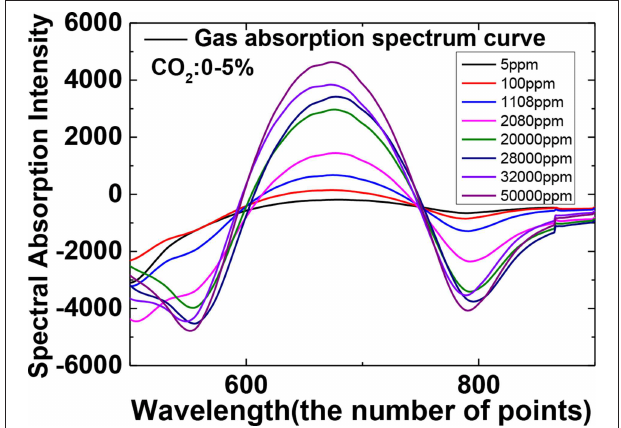
FIGURE 7 | The extracted WMS-2f signals within the CO 2 concentration range of 0 ∼ 5%.